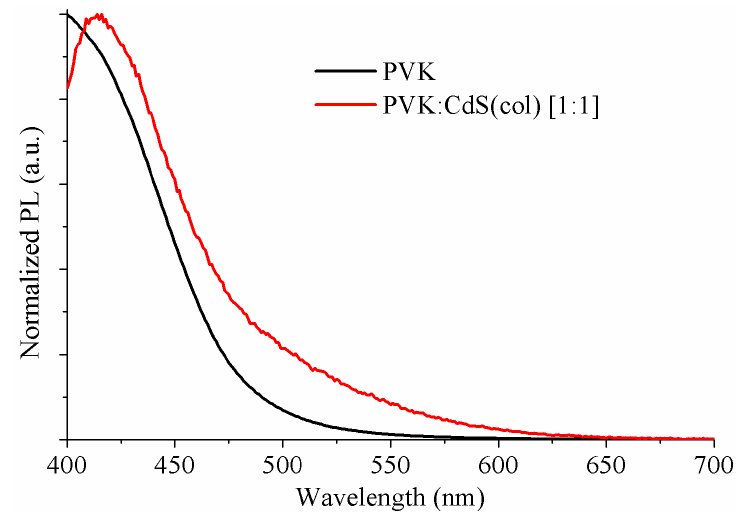
Figure 2. The normalized PL spectra of the active layer solutions: (black) PVK and (red) PVK:CdS(col) [1:1].